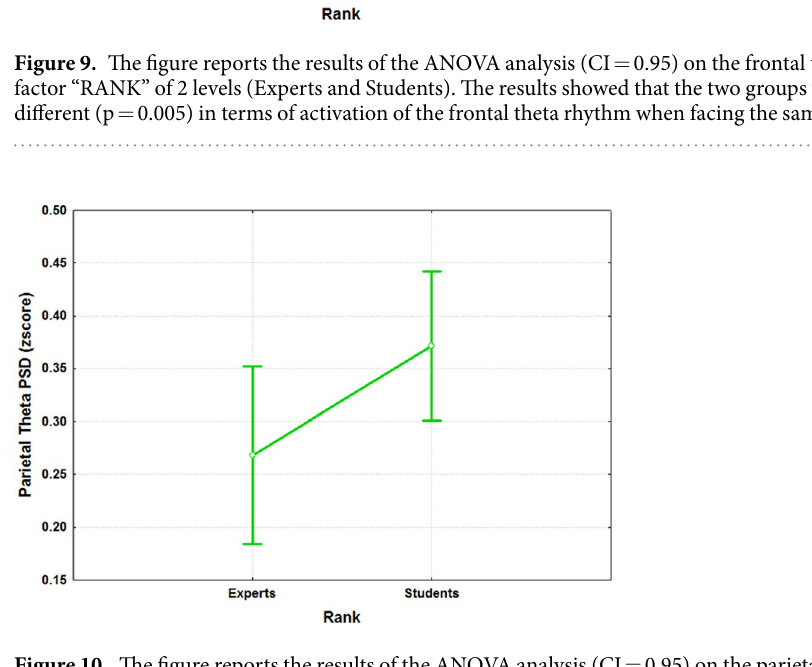
Figure 10. The figure reports the results of the ANOVA analysis (CI = 0.95) on the parietal theta PSD with the factor “RANK” of 2 levels (Experts and Students). The results showed that the two groups were statistically different (p = 0.0023) in terms of activation of the parietal theta rhythm when facing the same S, R and K